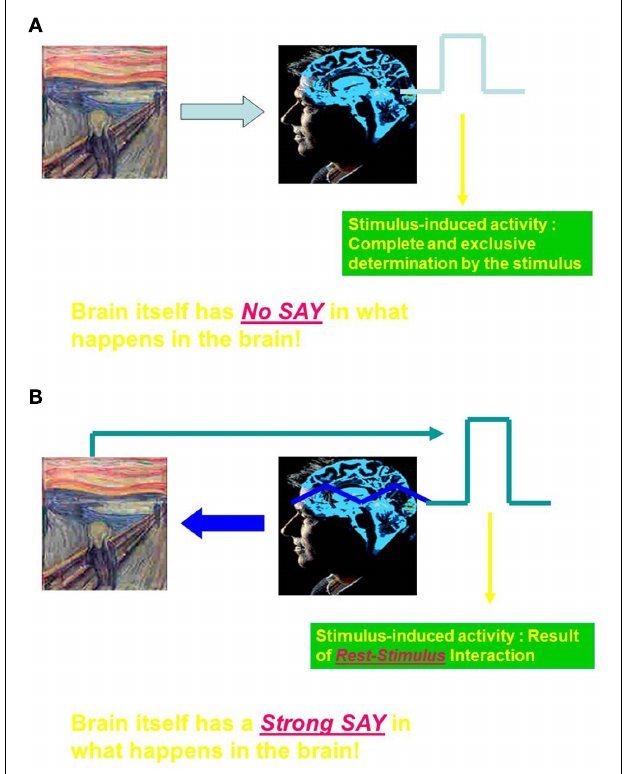
FIGURE 1 | (A) Extrinsic view- brain as behavioral-cognitive reflex apparatus (Sherrington, cognitive neuroscience). (B) Intrinsic view- brain as active player in its neuronal activity (Brown, Lashley, Llinas, Shulman,